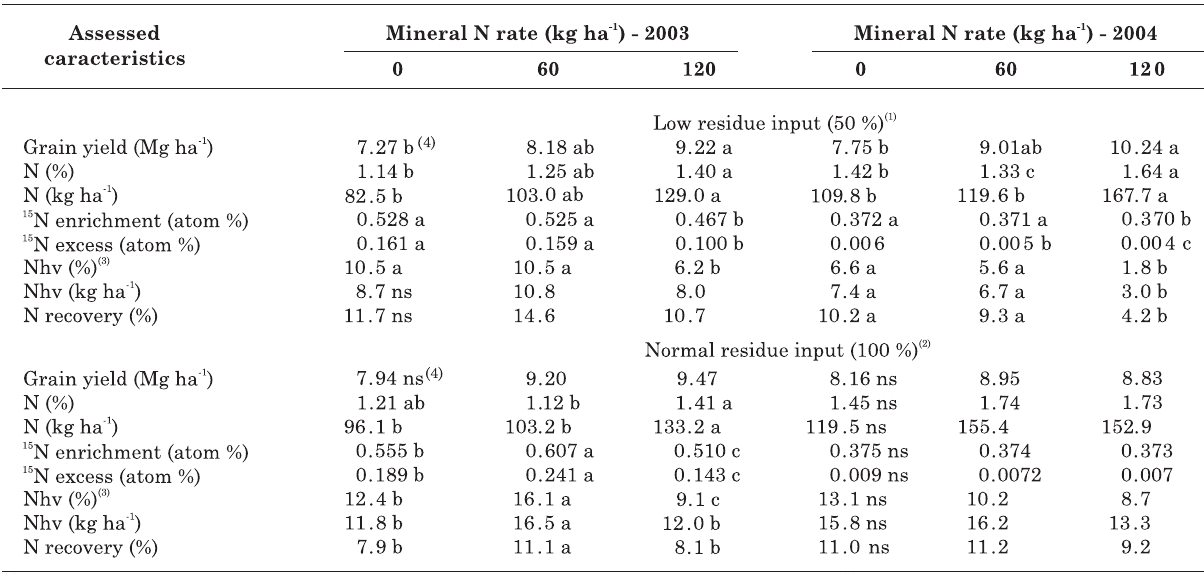
Table 2. Maize grain yield and isotopic properties of the 15 N recovery in maize grains (first year) as a function of mineral N fertilization rates and levels of hairy vetch residue input in 2003 and